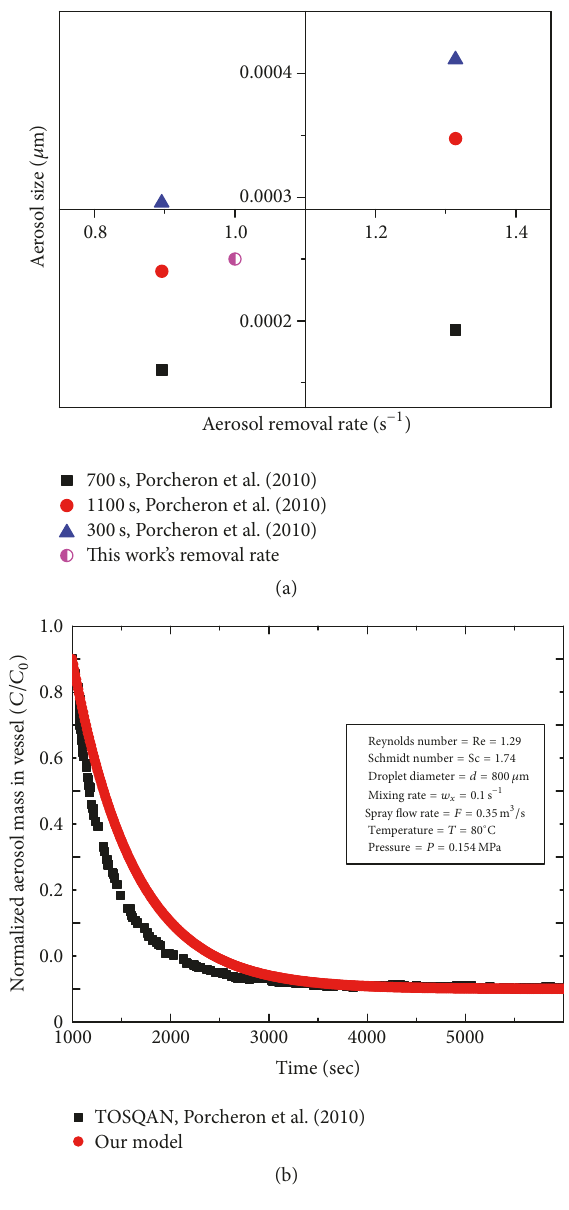
Figure 17: A comparison of removal rate (a) and normalized aerosol mass (b) with TOSQAN